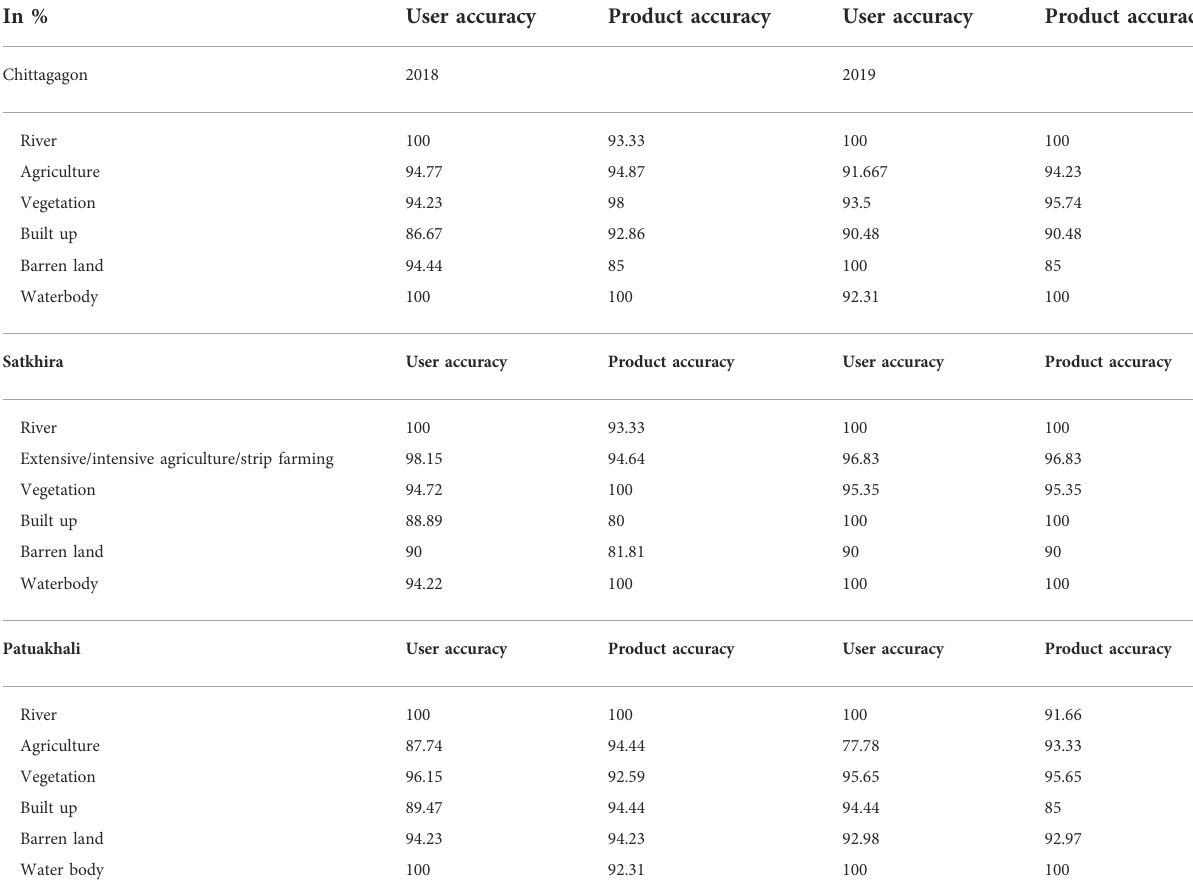
TABLE 1 User accuracy and product accuracy of each land use pattern for 2018 and 2019 with respect to three considered districts. In